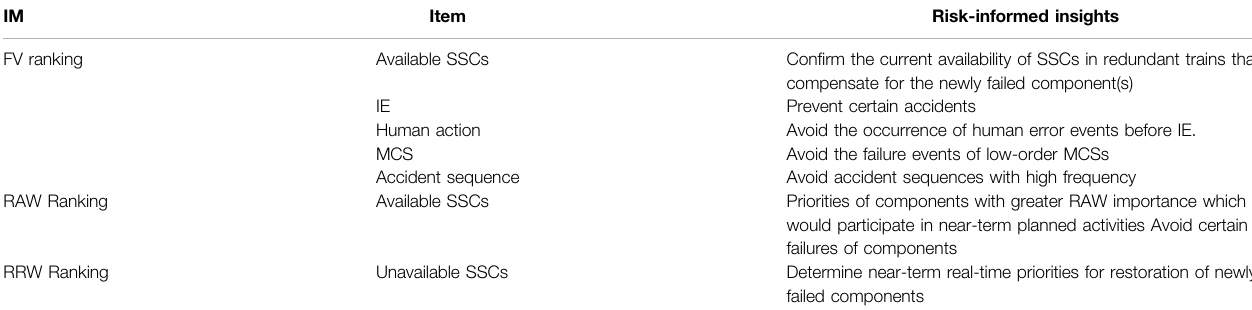
TABLE 5 | Risk-informed insights for online operation and maintenance using relative rankings of